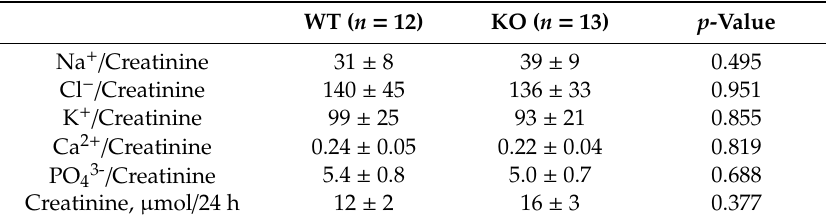
Table 3. Urinary ion excretion.